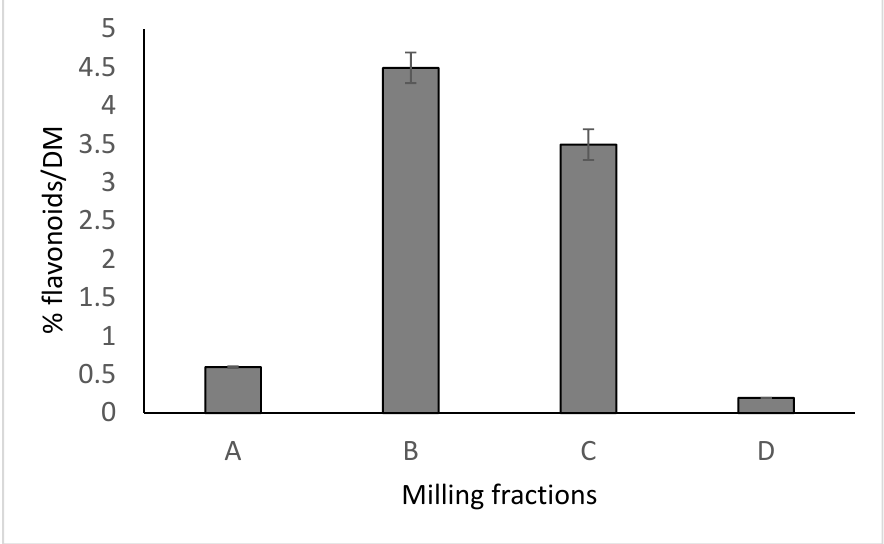
Figure 2. Distribution of flavonoids among Tartary buckwheat milling fractions.